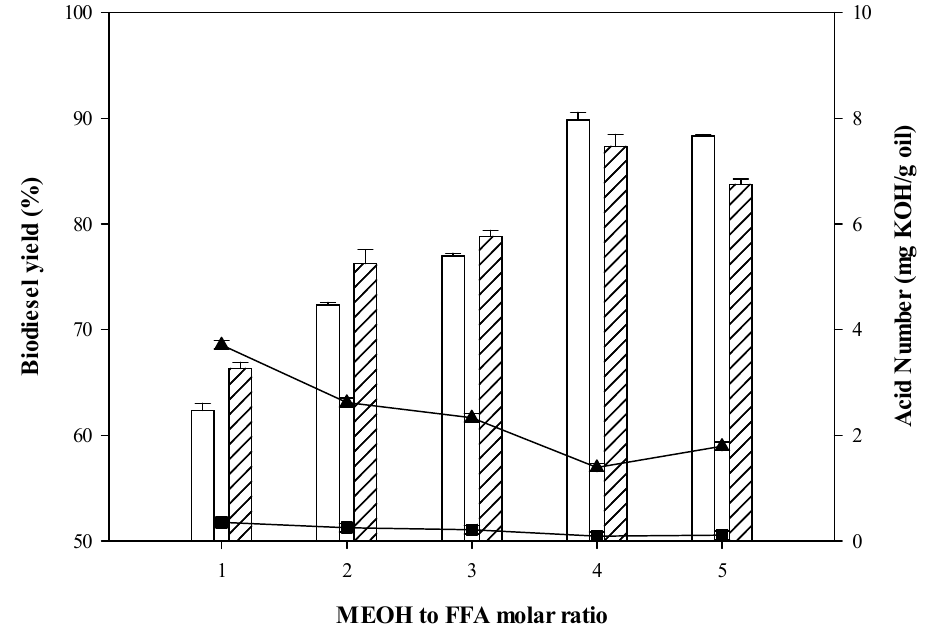
Figure 2. Biodiesel yield (%) as function of MeOH to FFA molar ratio and acid number (mg KOH/g oil) (CPO biodiesel yield RPO biodiesel yield ▲ CPO acid number ■ RPO acid number).